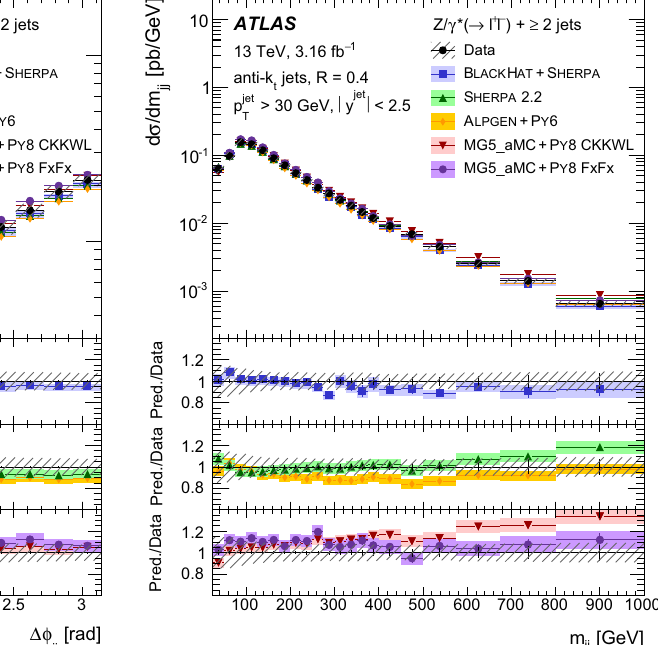
correspond to the statistical uncertainty, and the hatched bands to the data statistical and systematic uncertainties (including luminosity) addedinquadrature.Thedetailsofthepredictionuncertaintiesaregiven in the